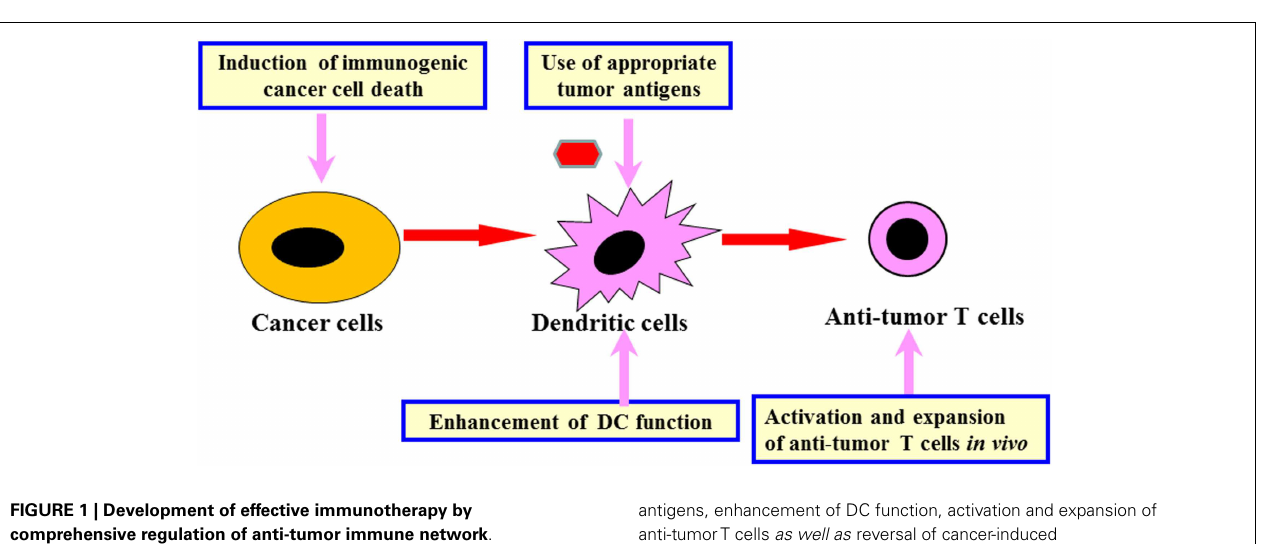
FIGURE 1 | Development of effective immunotherapy by comprehensive regulation of anti-tumor immune network . Comprehensive regulation of anti-tumor immune network, including induction of immunogenic cancer cell death, use of appropriate tumor